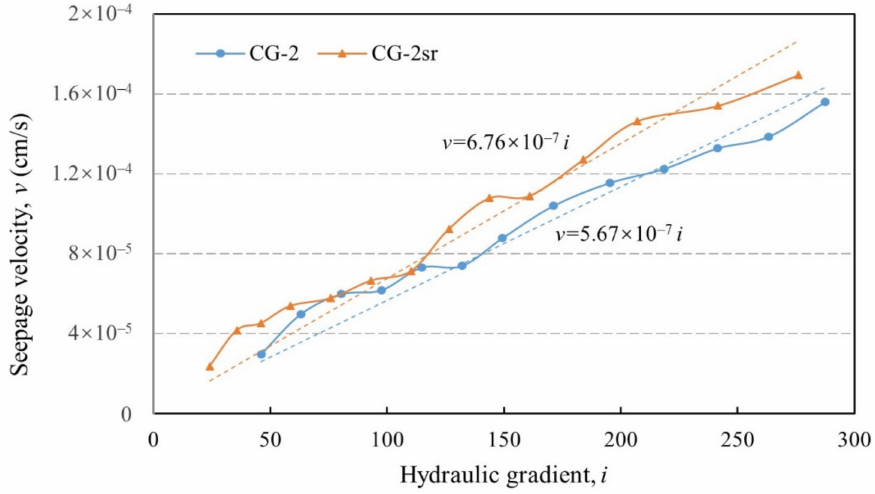
Figure 10. v–i relationships under true triaxial stress state ( σ x = 3.5 MPa, σ y = 2.5 MPa, σ z = 4.5